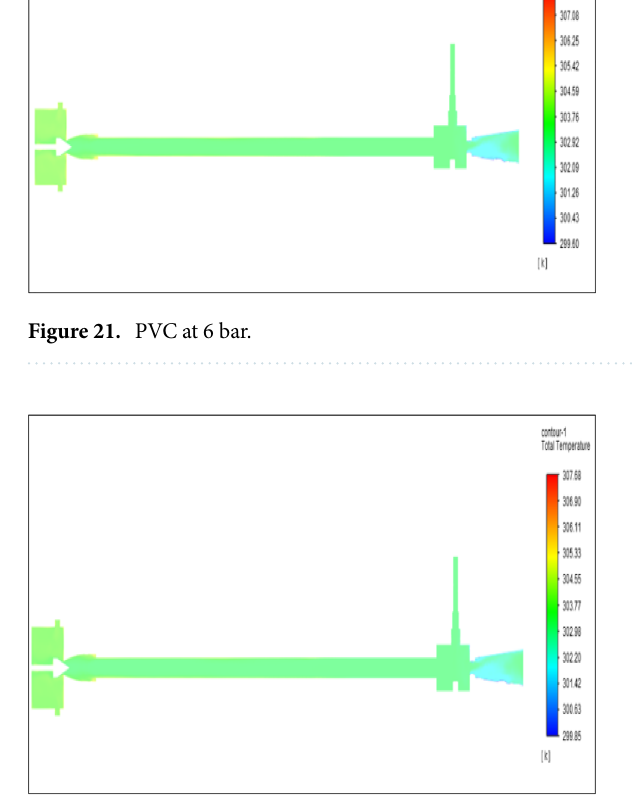
Figure 22. CPVC at 6 bar.